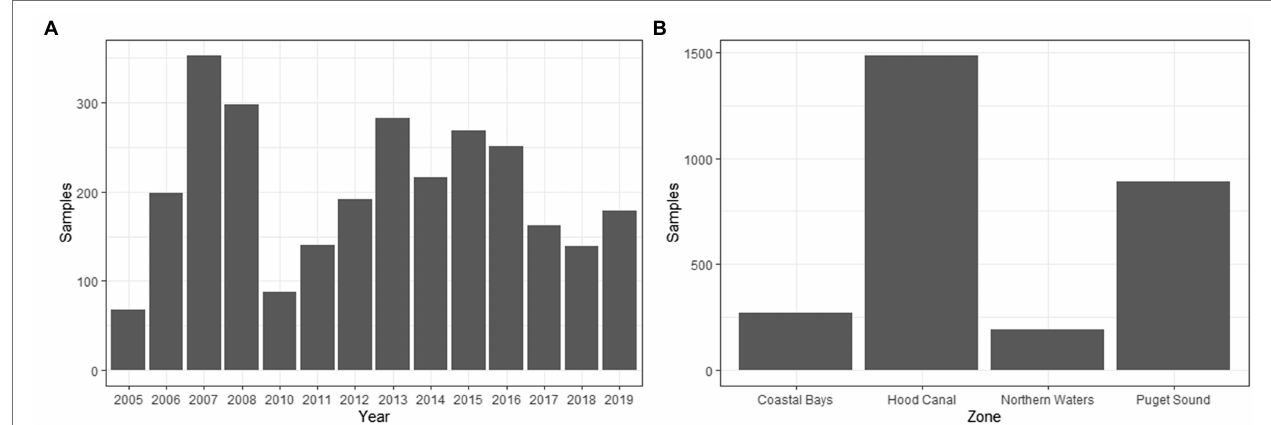
FIGURE 3 | Cumulative oyster sampling reported by (A) year and (B)